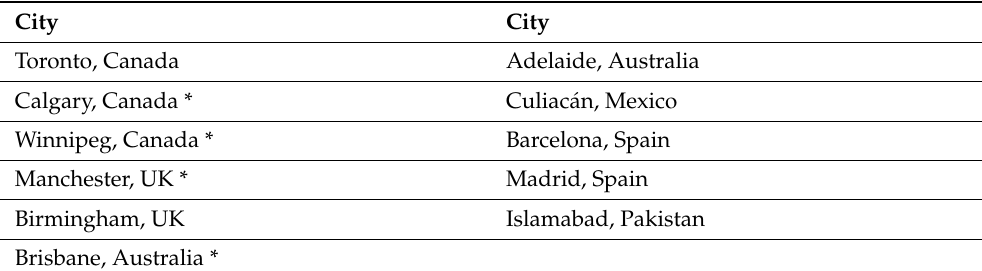
Table 4. International city comprehensive